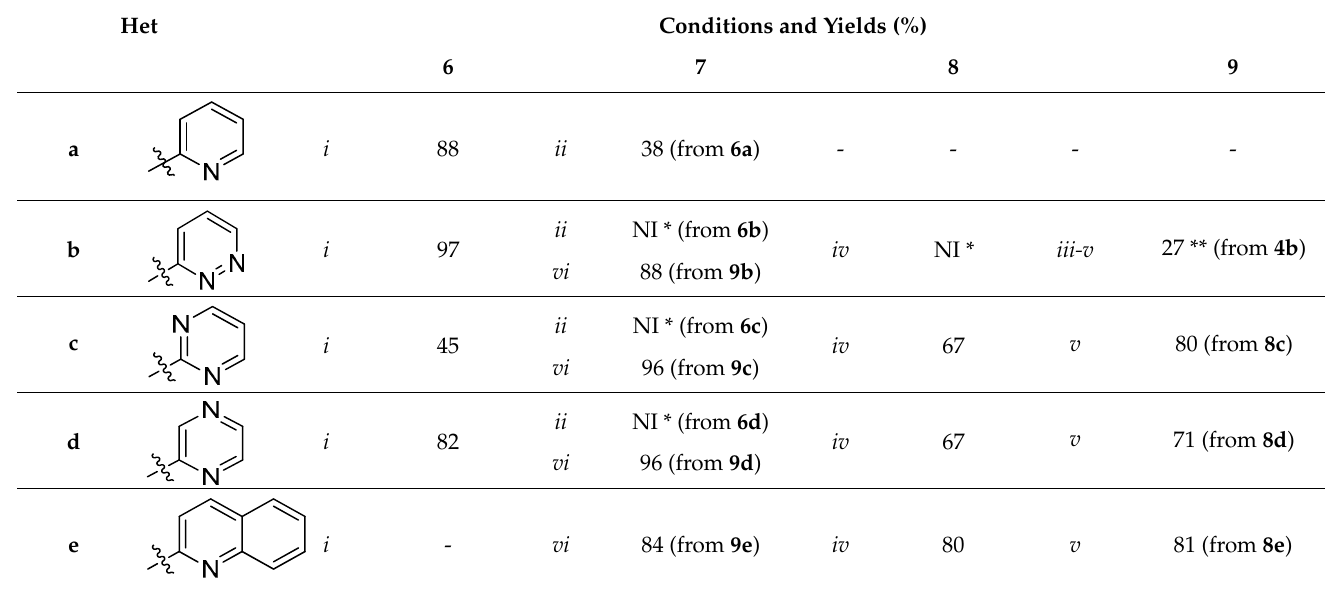
Table 3. Synthesis of C -(2 ′ -amino-2 ′ -deoxy-3 ′ ,4 ′ ,6 ′ -tri- O -benzoyl- β - D -glucopyranosyl)azines.